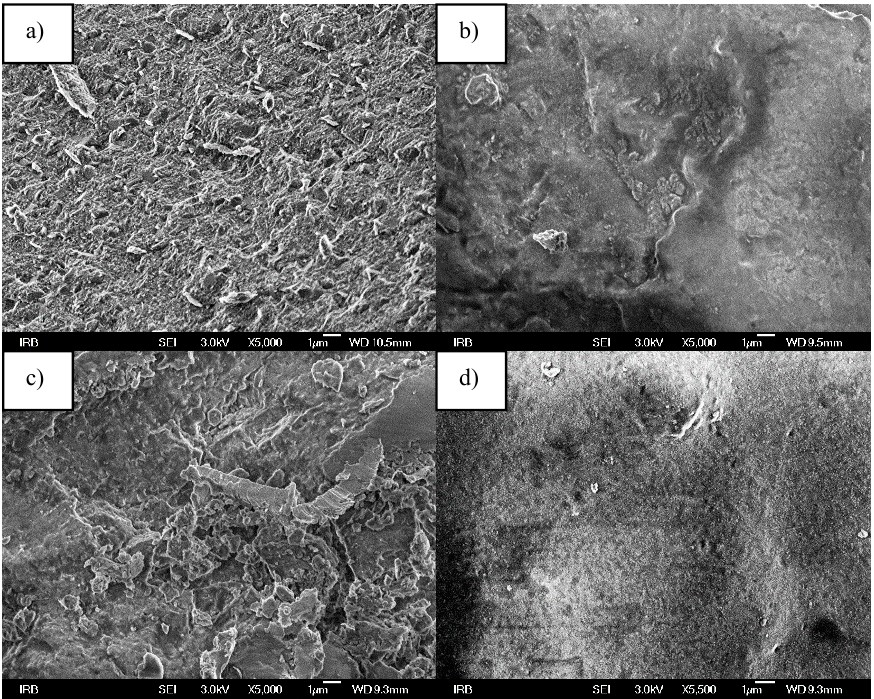
Figure 1. SEM images of the as-received samples ( a ) LS10, ( b ) LS11, ( c ) LS20, and ( d ) LS21. The crystallization effect can be observed in ( b ) and ( d ). Magnification is ×5000.